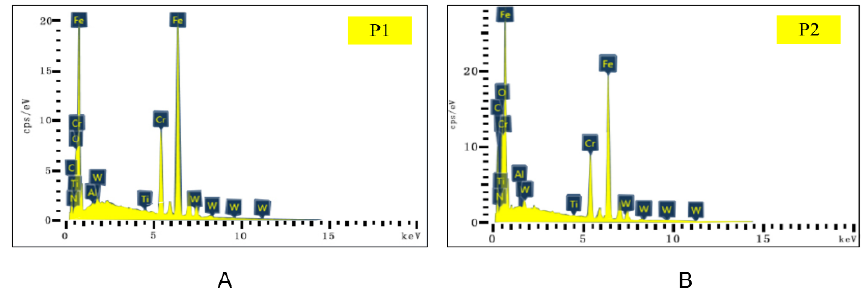
Figure 16. EDS analysis results of corresponding points P1 ( A ) and P2 ( B ) in Figure 15.